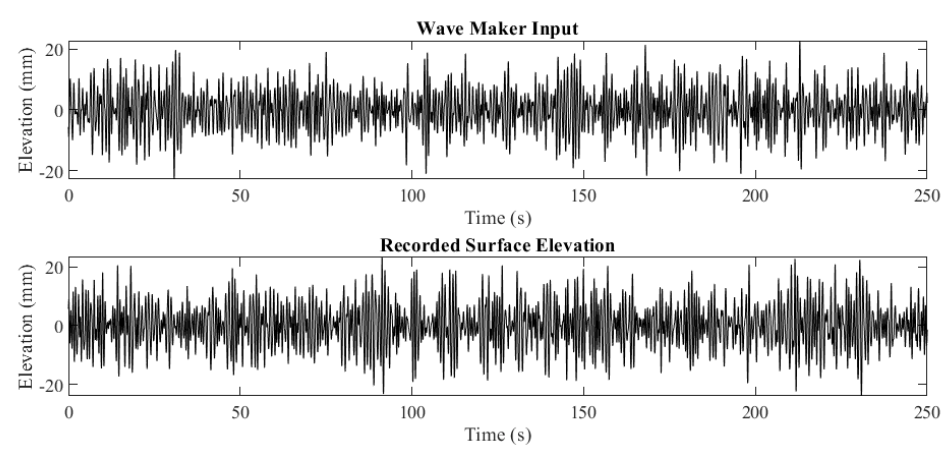
Figure 5. Designed and recorded wave surface elevation for the Bretschneider spectra.